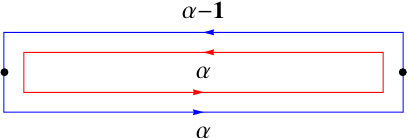
Figure 1 . The schematic plot of the Keldysh contour and twist operator. The blue and red contours represent subsystem a = 1 and a = 2, respectively. The black dots at two ends of contour represent twist operators. The red contour is the (cid:11) replica while in s = (cid:0) of the blue contour it changes to (cid:11) (cid:0) 1 due to the twist